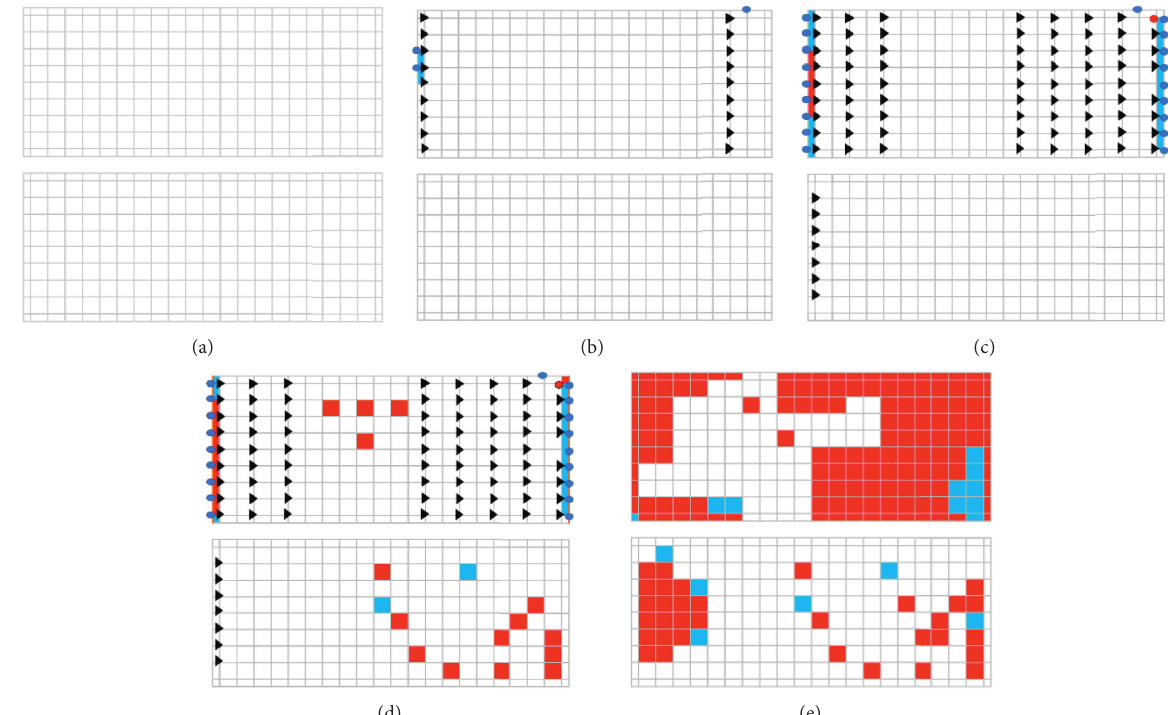
Figure 13: Damage process of the specimen. (a) Before run 26, (b) 0.25g ( Y ) sweep (run 26), (c) 0.35g ( X ) sweep (run 28), (d) 0.35g ( Y ) sweep (run 30), and (e) 0.5 g ( X ) sweep (run 32). Notes: represents unseating of grid; represents buckling of wall angle; represents axial buckling or shear deformation of main-cross tee connection; represents dislodgement of panel; and represents falling of